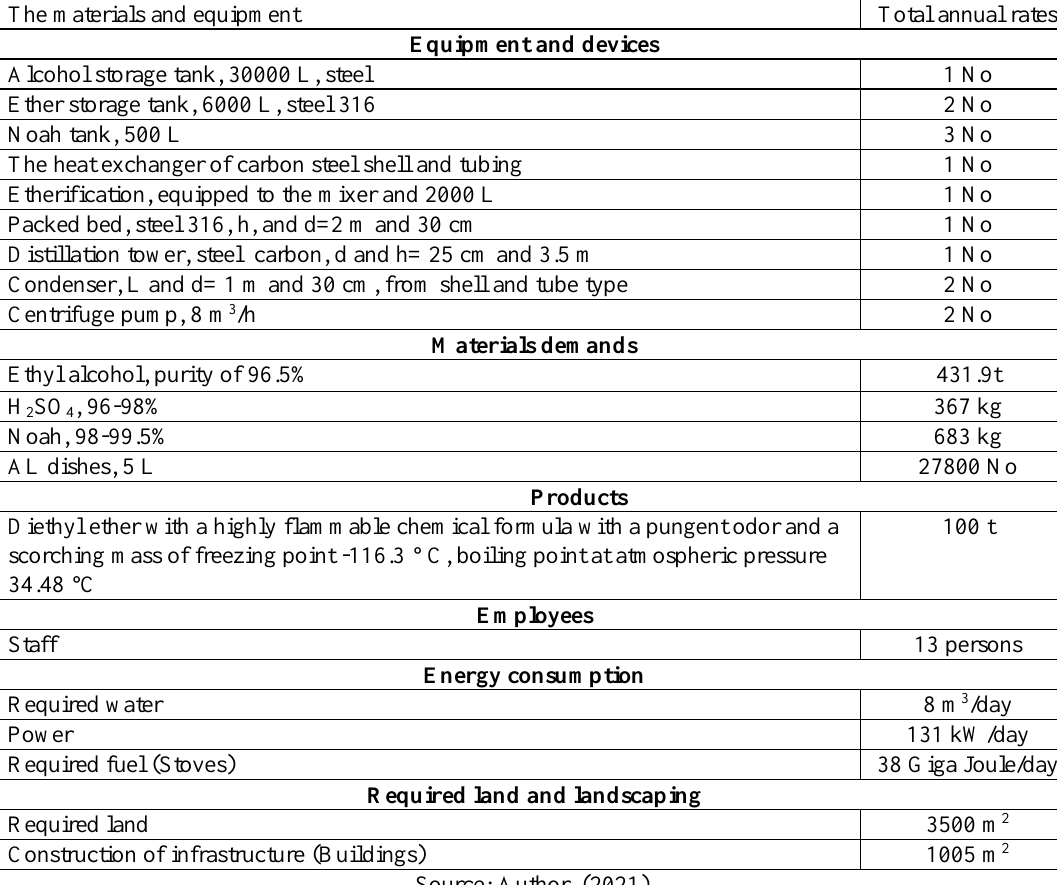
Figure 7: The layout of units of Diethyl ether generation industries. Table 6: The annual requirements of industries of Diethyl ether (nominal capacity of 100